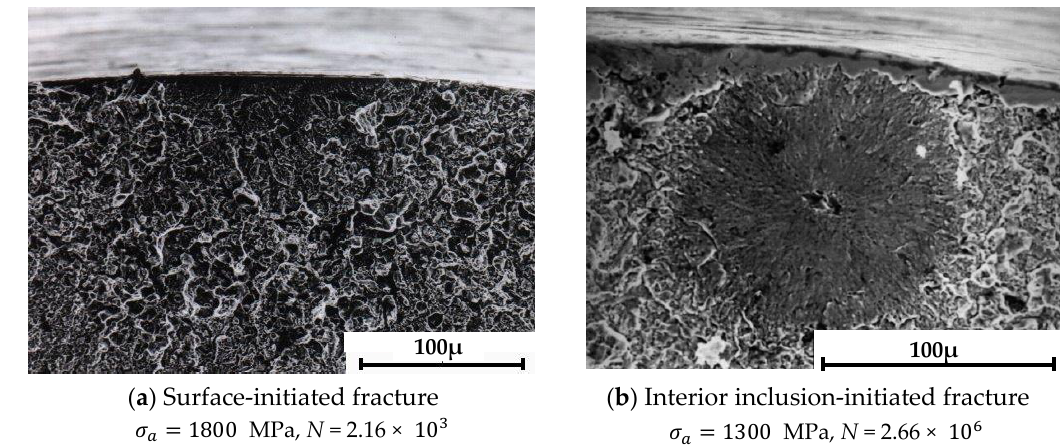
Figure 2. SEM observations of fracture surfaces in surface-induced fracture and interior inclusion-induced fracture.